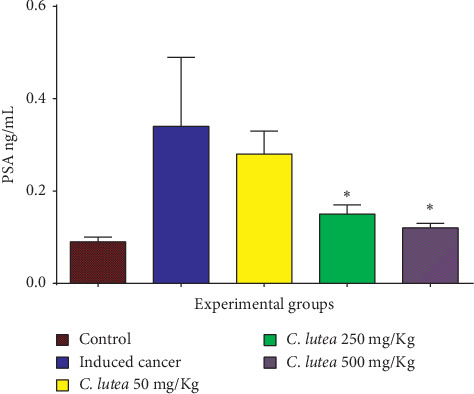
PSA levels in rats with induced prostate cancer after 5 months of treatment with Cordia lutea. ∗(P < 0.05) vs. induced cancer group.